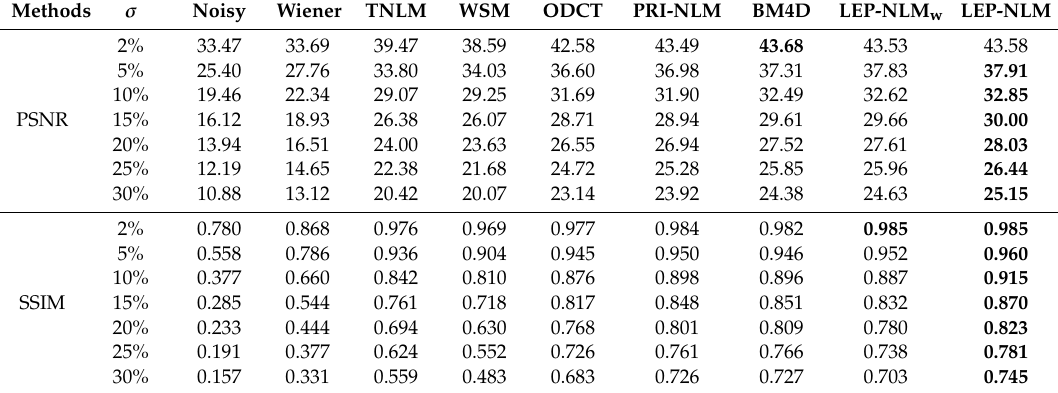
Table 1. PSNR / dB and SSIM comparison on the simulated PD-weighted images at di ff erent noise levels for the Wiener, TNLM, WSM, ODCT, PRI-NLM, BM4D, LEP-NLM, and LEP-NLM w methods. Methods